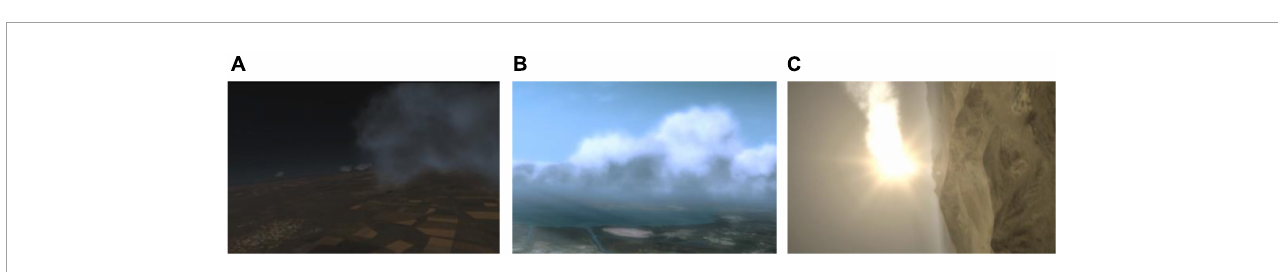
FIGURE2 Dynamic flight scene videos of night, day, and complex environment. (A) Night scene. (B) Day scene. (C) Complex environment